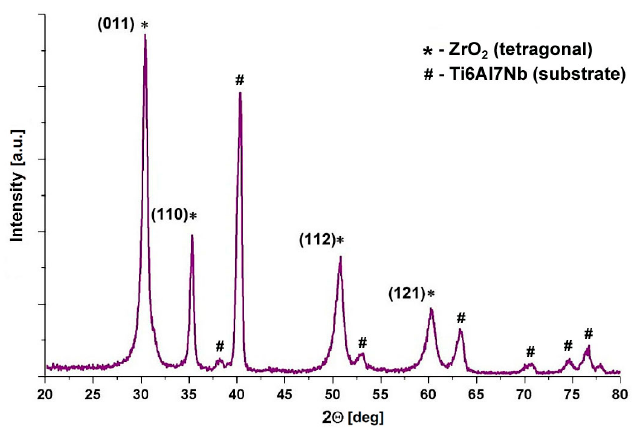
Figure 7. Di ff raction pattern of ZrO 2 coating deposited on the Ti6Al7Nb alloy Figure 7. Diffraction pattern of ZrO 2 coating deposited on the Ti6Al7Nb alloy substrate.